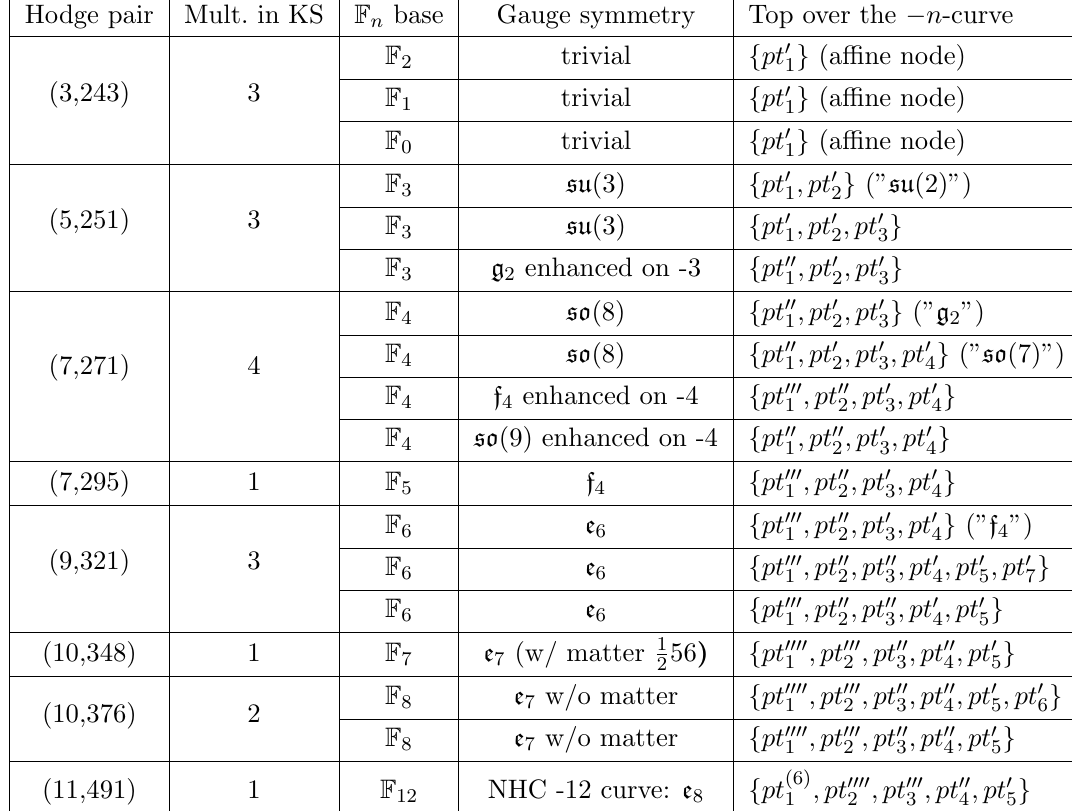
Table 10. Polytope models associated with generic elliptic (cid:12)brations over the Hirzebruch surfaces F 0 ; 1 ;:::; 8 ; 12 , as well as all other models with the same Hodge numbers. Alternate constructions include multiple tops, some due to monodromy conditions in Tate tunings, as well as rank-preserving tunings (section